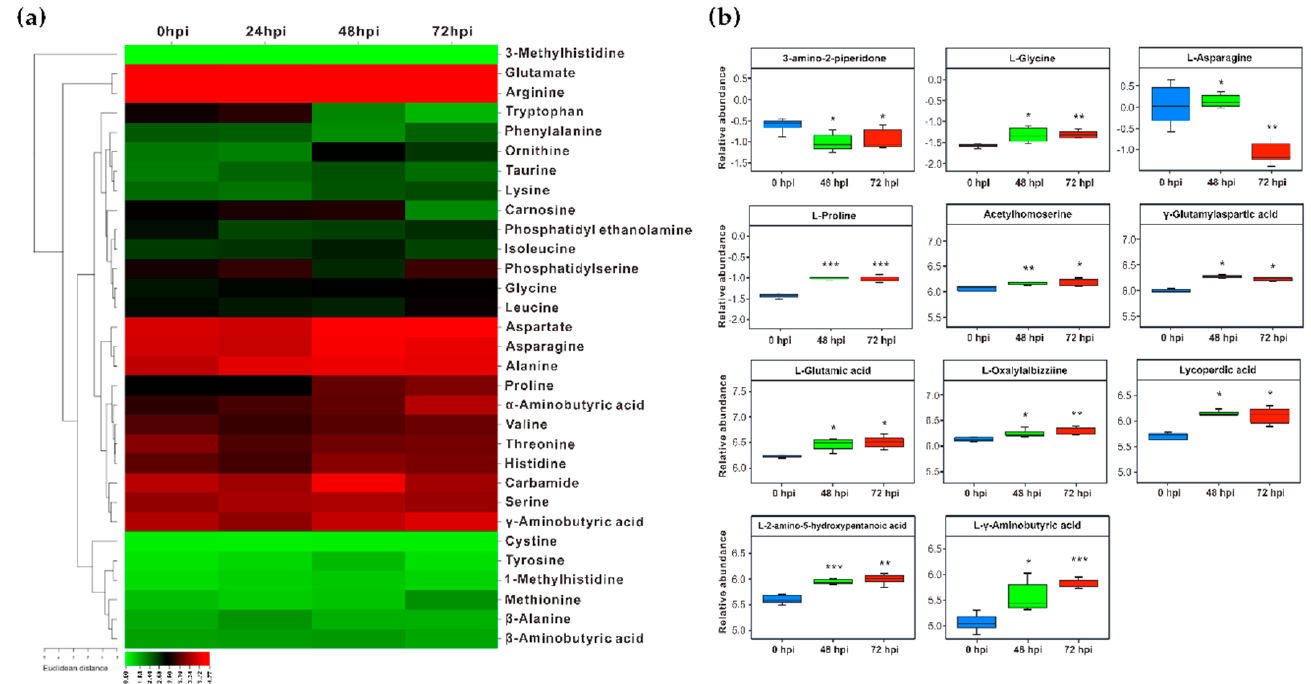
Figure 5. Quantification of the perturbed free amino acids and derivatives in Asp metabolic pathways upon Fs infection in roots. ( a ) The heatmap shows the quantified metabolites by HPLC. ( b ) Relative validation of the significantly altered metabolites, based on the non-targeted metabolomics (LC-/GC-MS) analyses. For the HPLC assay, the Log mean values (n mol/g fresh weight) were used to represent the levels of three independent biological replicates. For non-targeted metabolomics, data represent Log relative mean values based on six independent biological replicates. The asterisks indicate significant differences relative to the control using Student’s t -test: *** p < 0.001, ** p < 0.01, and * p < 0.05.